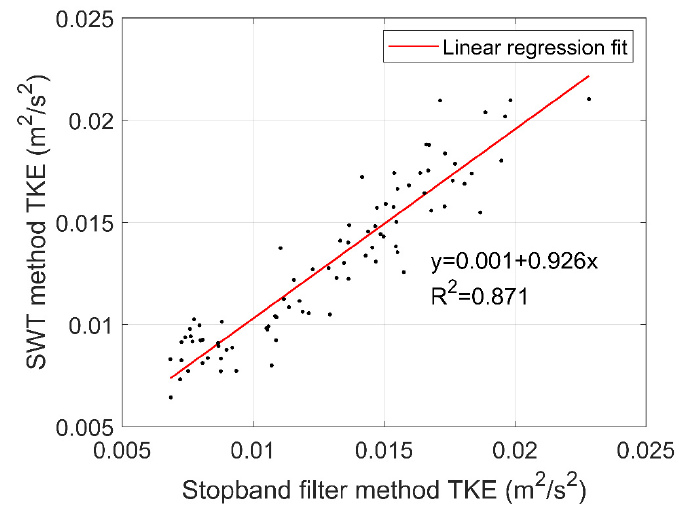
Figure 9. Linear regression fit between total TKE estimates at hub-height from instrument CTb3 obtained with the SB filter and the SWT methods.